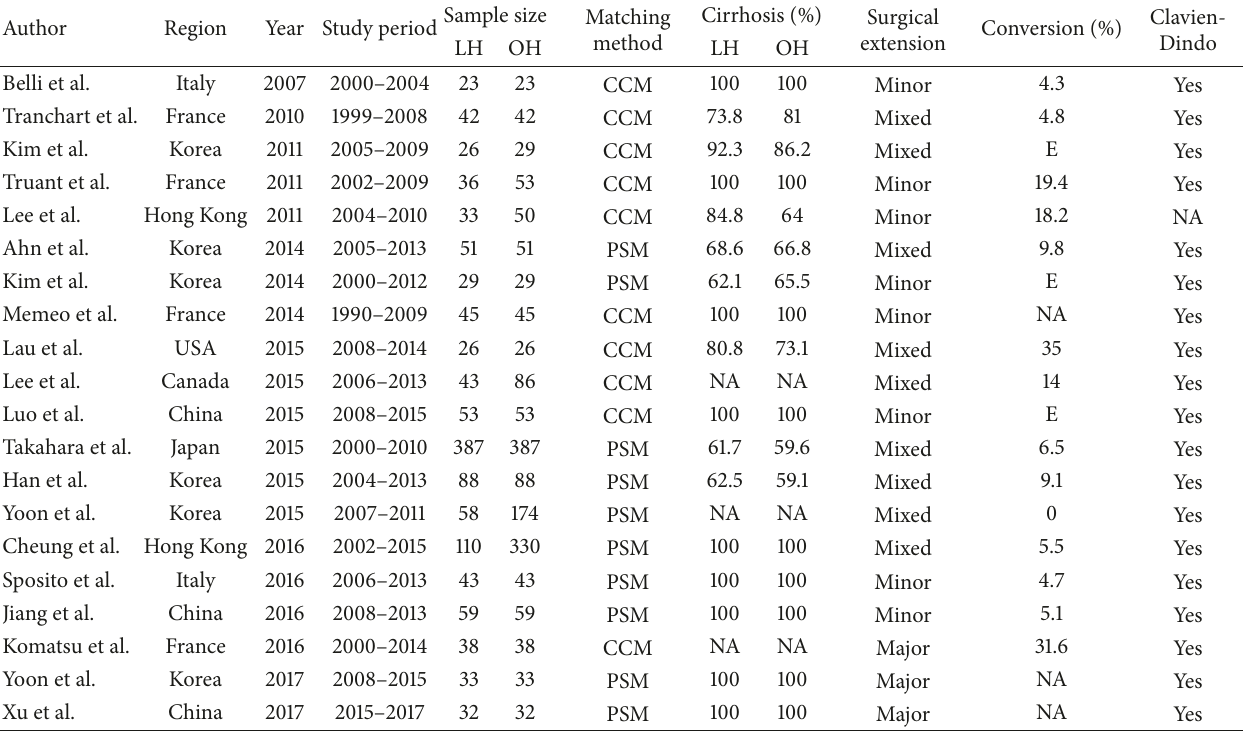
Table 1: Basic information of the included literature.